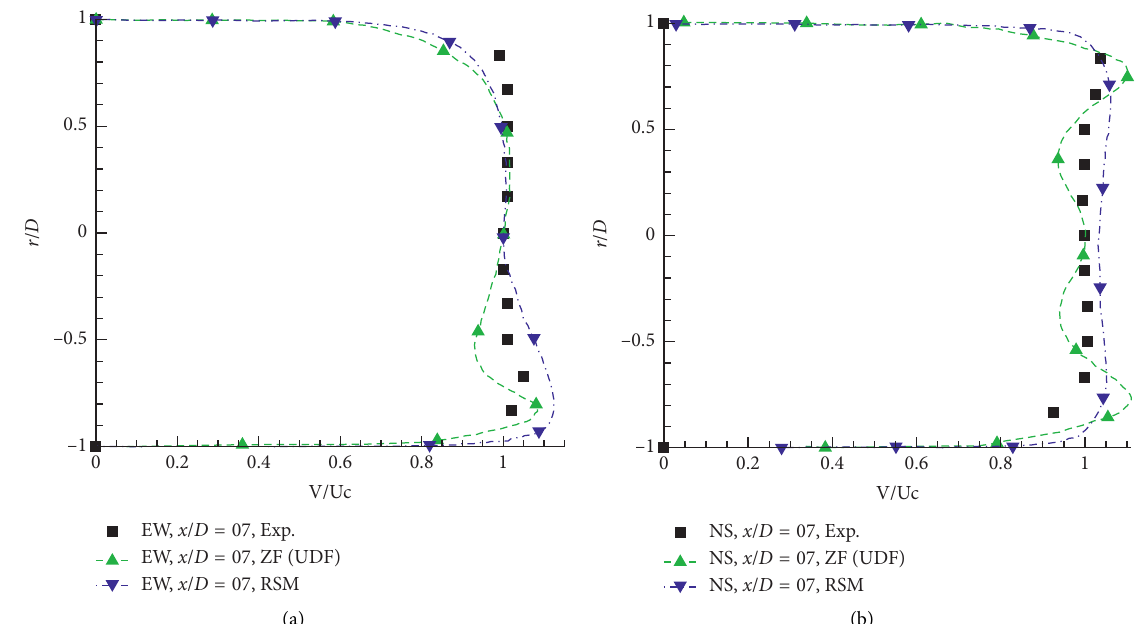
Figure 7: Normalized velocity profiles for different turbulence models at x / D �